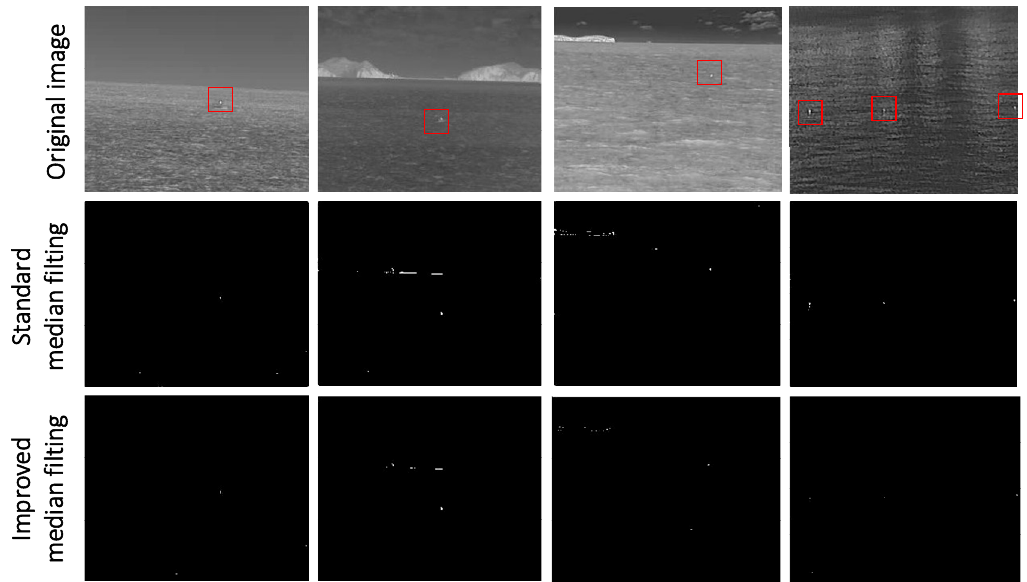
Figure 10. Comparison of the effect of two kinds of filters for target extraction